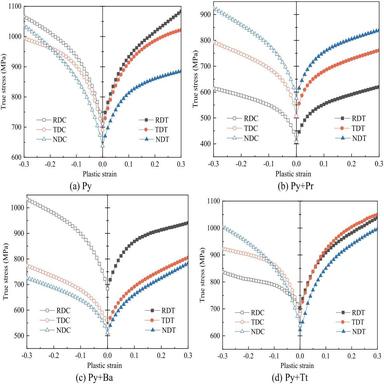
True stress-plastic strain curves and R-values of the α-Ti tube with different combinations of deformation mechanisms in the thought experiment, indicating that the twinning has much more contributions to the distorted evolution of plasticity, and the R-value is significantly affected by deformation mechanisms.